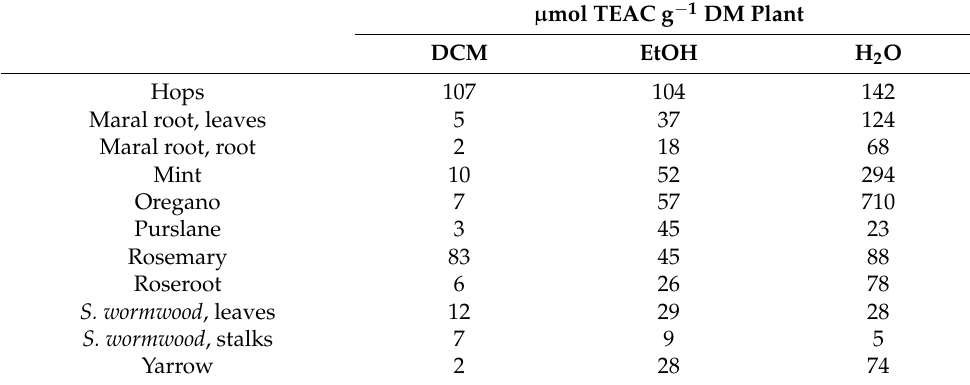
Table 3. Combination of extraction yields and radical scavenging